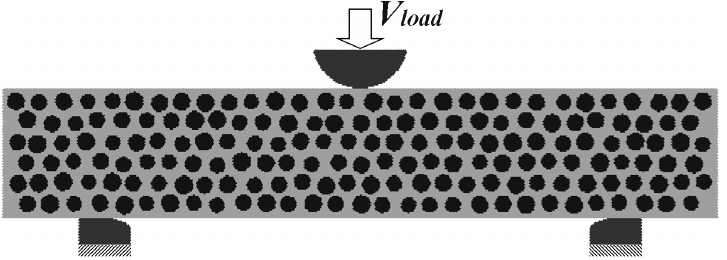
Figure 12: Scheme of the simulation of three-point bending test of the model composite